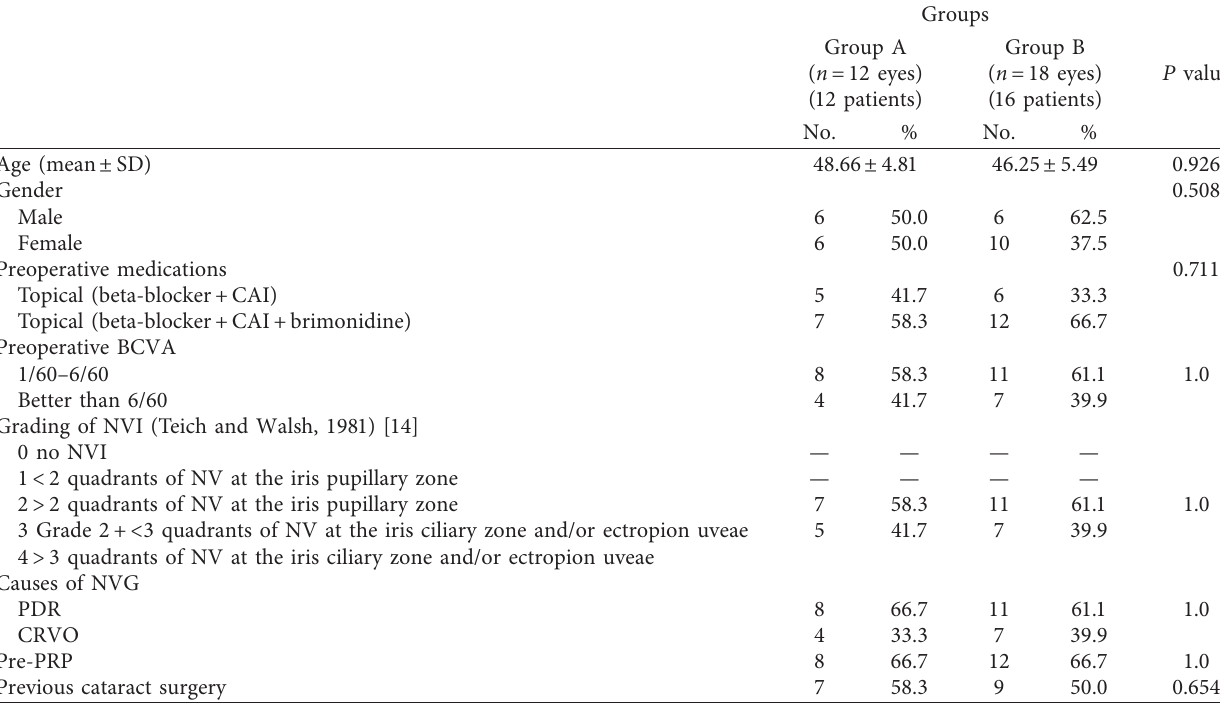
Table 1: Demographic data and baseline clinical findings.